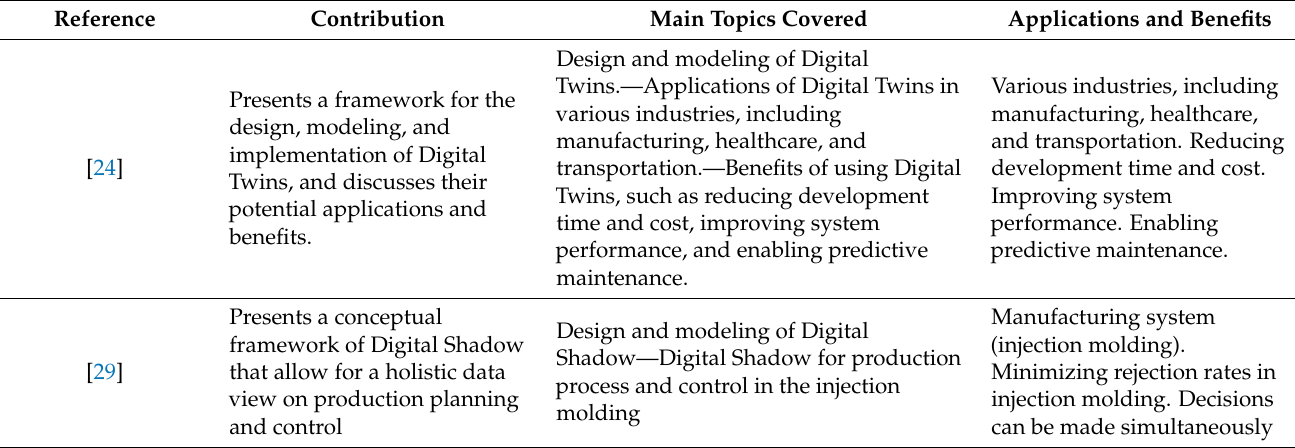
Table 4. Contribution/Comparison Current Paper with Other Key